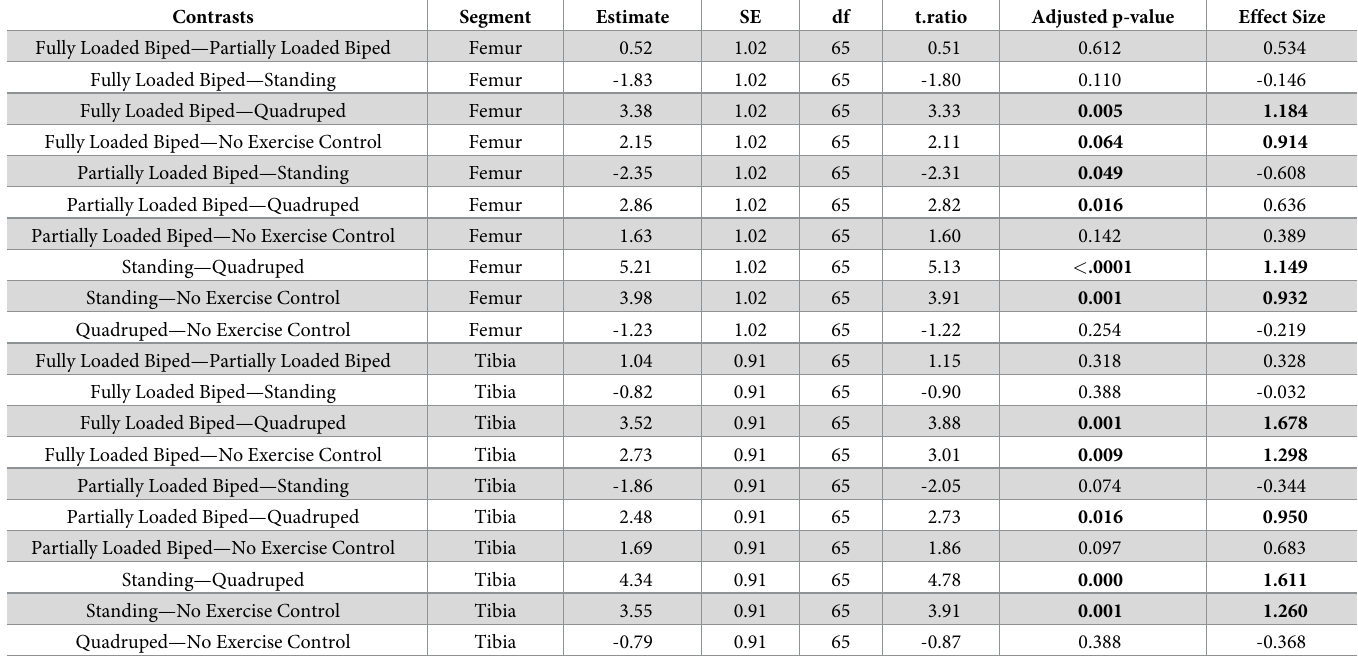
Comparisons were also made using the absolute change from baseline (i.e., Week 12-Week 0) using a mixed-effect model with body mass as a fixed effect (covariate) to control for body size. This analysis showed significant differences across experimental groups for change in the : 2.945, p = 0.027) and tibia (F : 4.864, p = 0.002). A multiple length of the femur (F [4,64] [4,64] Table 5. Least-squares means multiple comparisons table for percentage change in femur and tibia